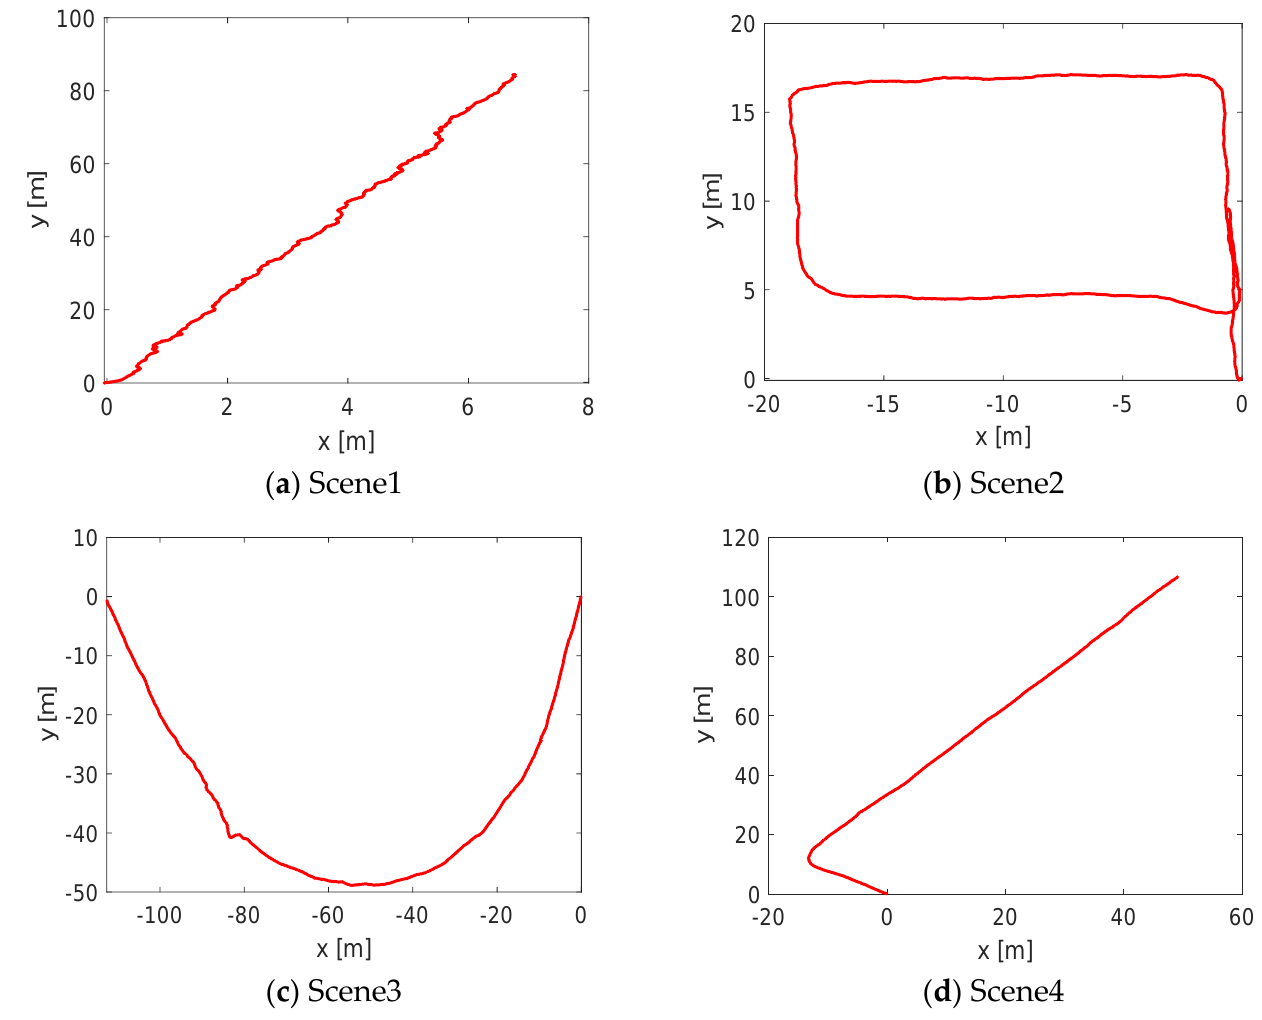
Figure 13. Localization trajectory of the four underground roadway scenes.